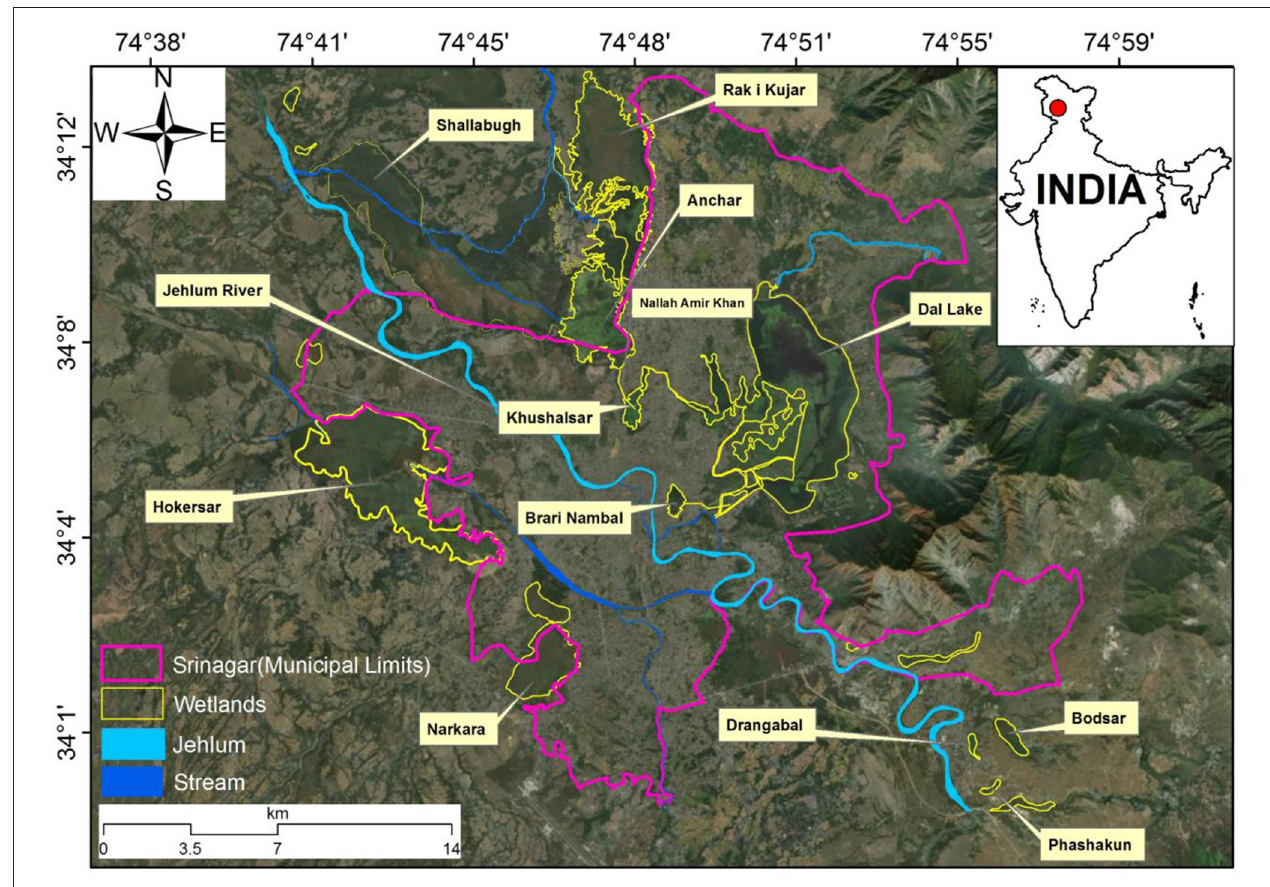
FIGURE 2 | Location of major wetlands in the Srinagar city and its vicinity.